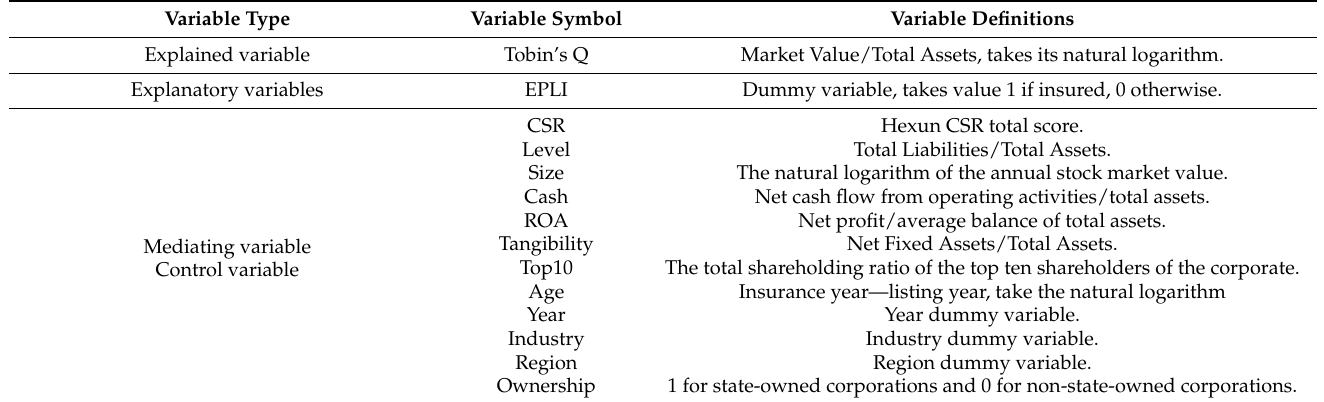
Table 2. Variable types and definitions.